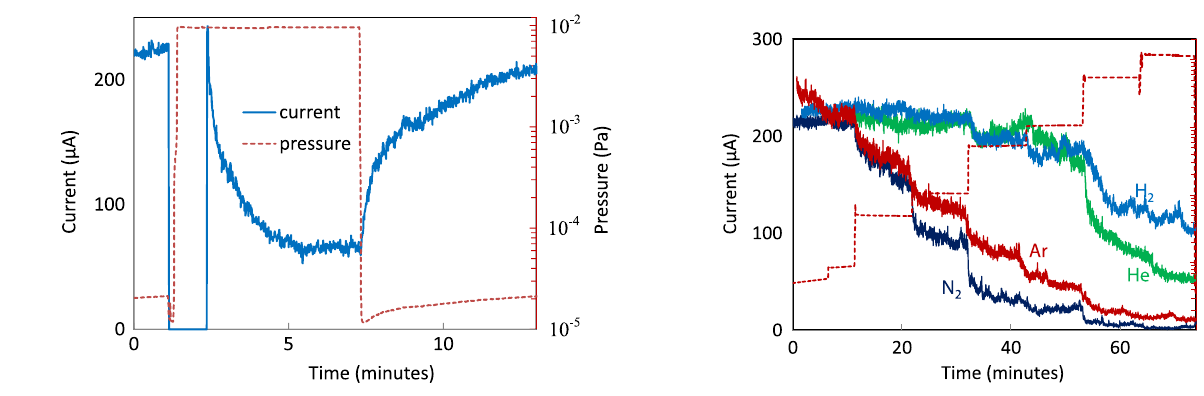
FIG. 3. Typical field emission current decrease and recovery caused by the injection and pumping down of helium: 2 cm gap distance, 30 kV applied voltage.